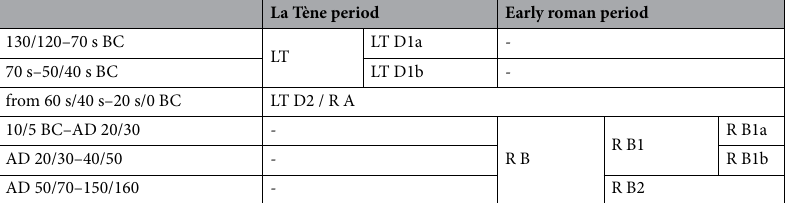
Table 1. Summary of the chronological system employed in the sample categorisation. The generally accepted chronological framework for the late La Tène 12 and the Early Roman period 22,44,54,55 , respectively, were